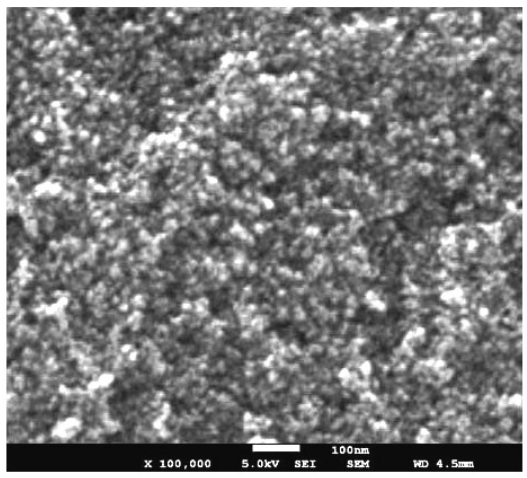
Fig.3 SEM image of Zn-doped SnO2